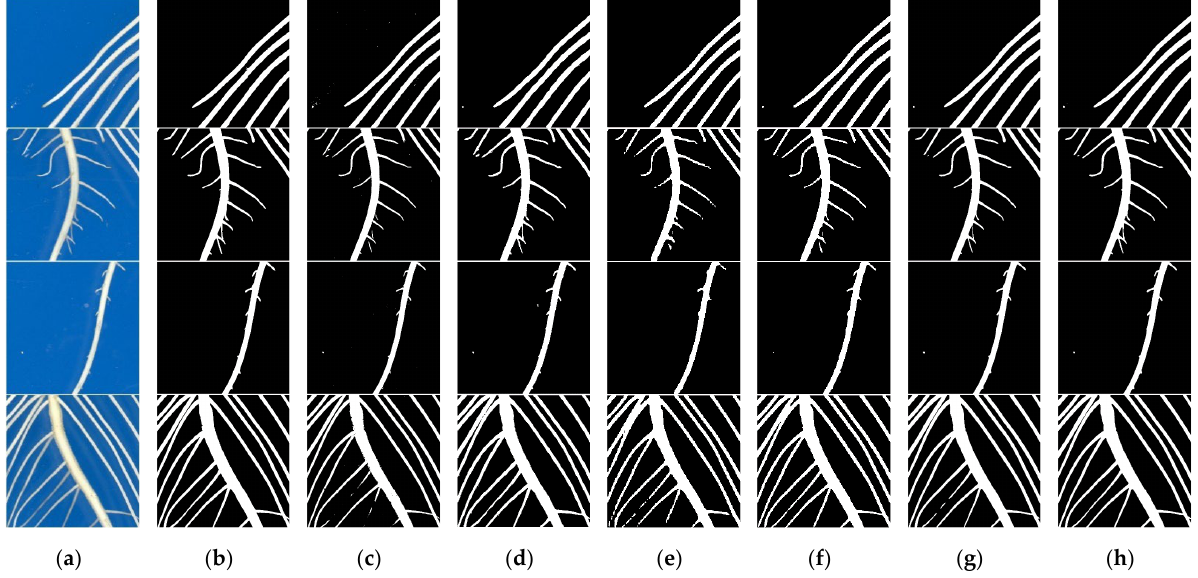
Figure 10. Comparison of segmentation results on different methods. ( a ) Original image; ( b ) An- notated image; ( c ) OTSU; ( d ) SegNet; ( e ) PSPNet; ( f ) DeepLabv3+; ( g ) U-Net; ( h ) Improved U-Net.